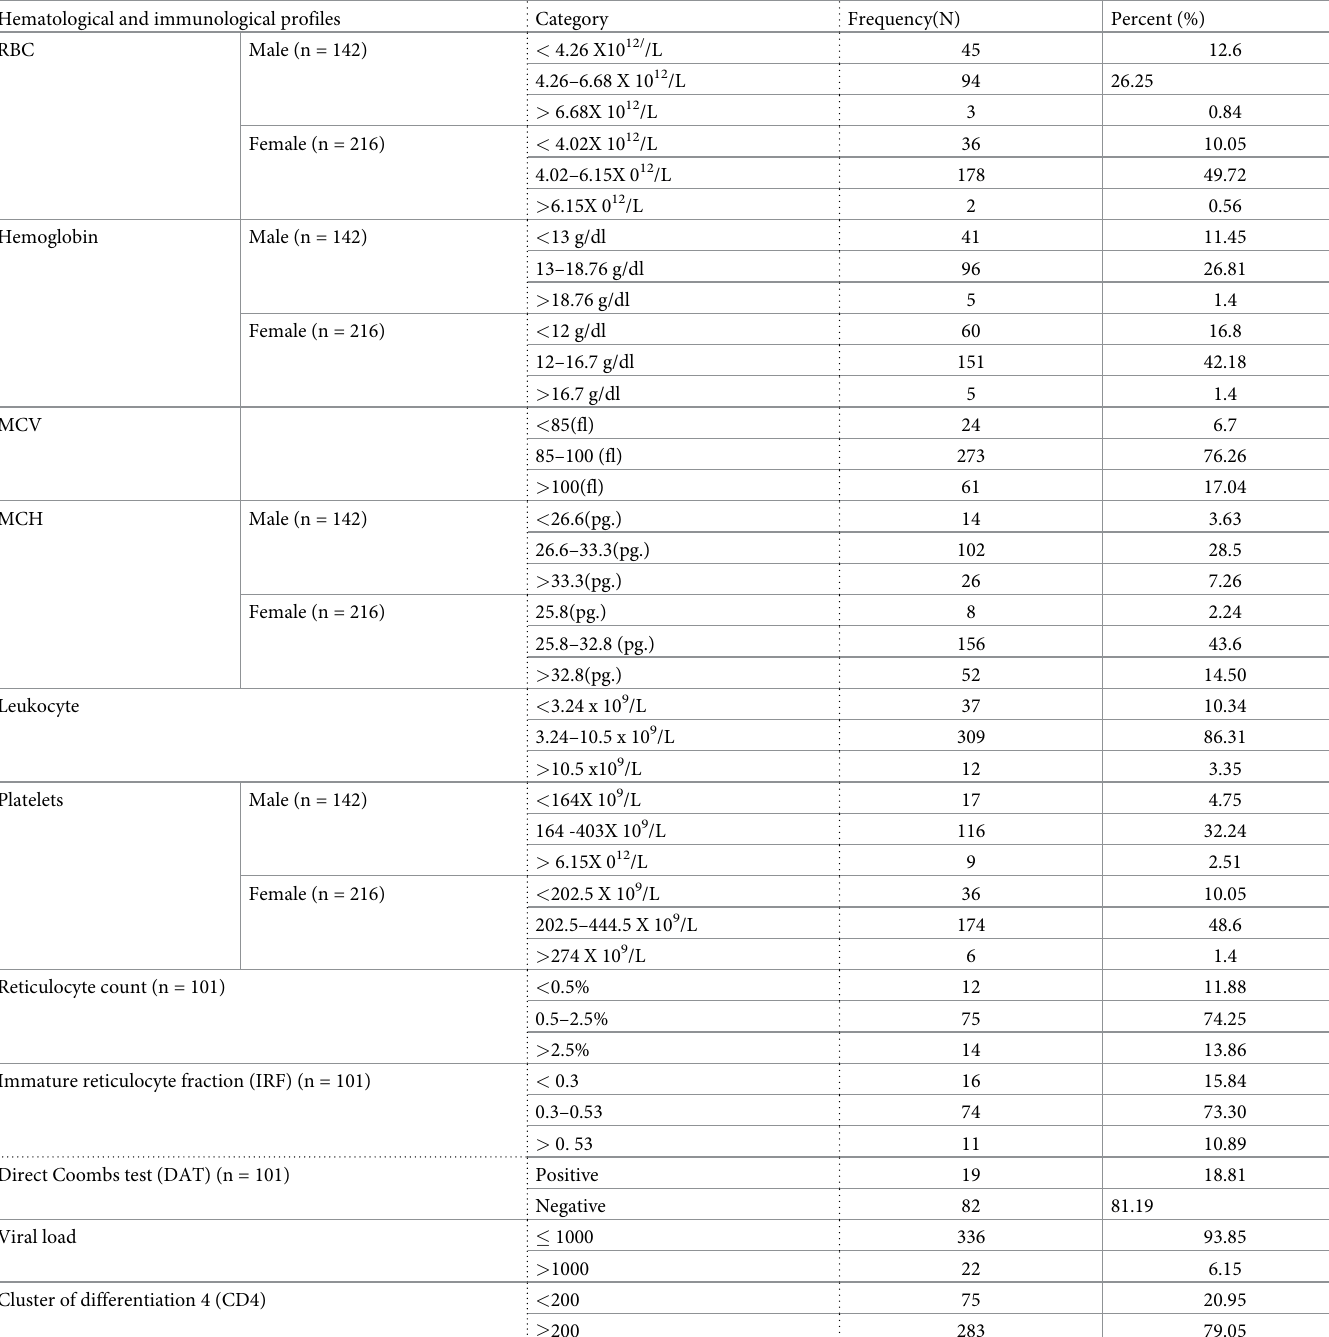
Table 3. Hematological and immunological profiles of study participants for magnitude of IHA in HIV infected adults at UOGCSH during March to April 2021 (N = 358). Hematological and immunological